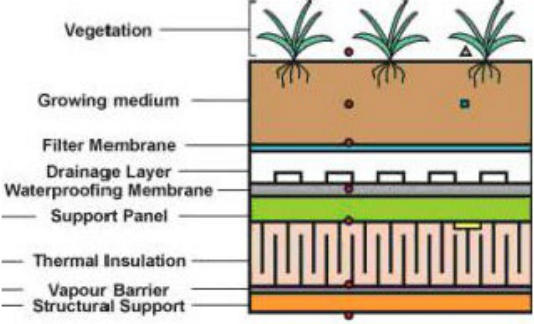
Figure 1. Typical cross-section of a green roof [31].